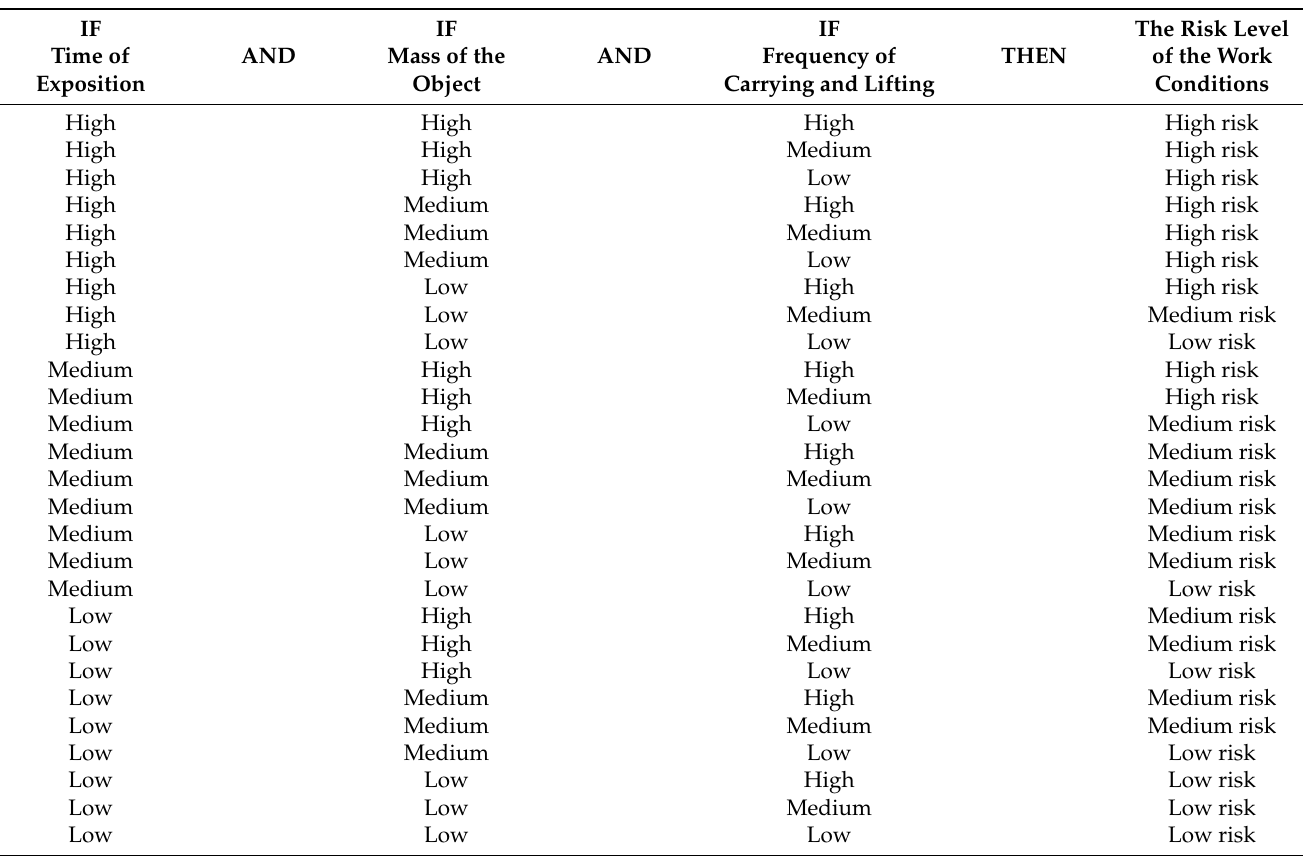
Table 4. Fuzzy rules.